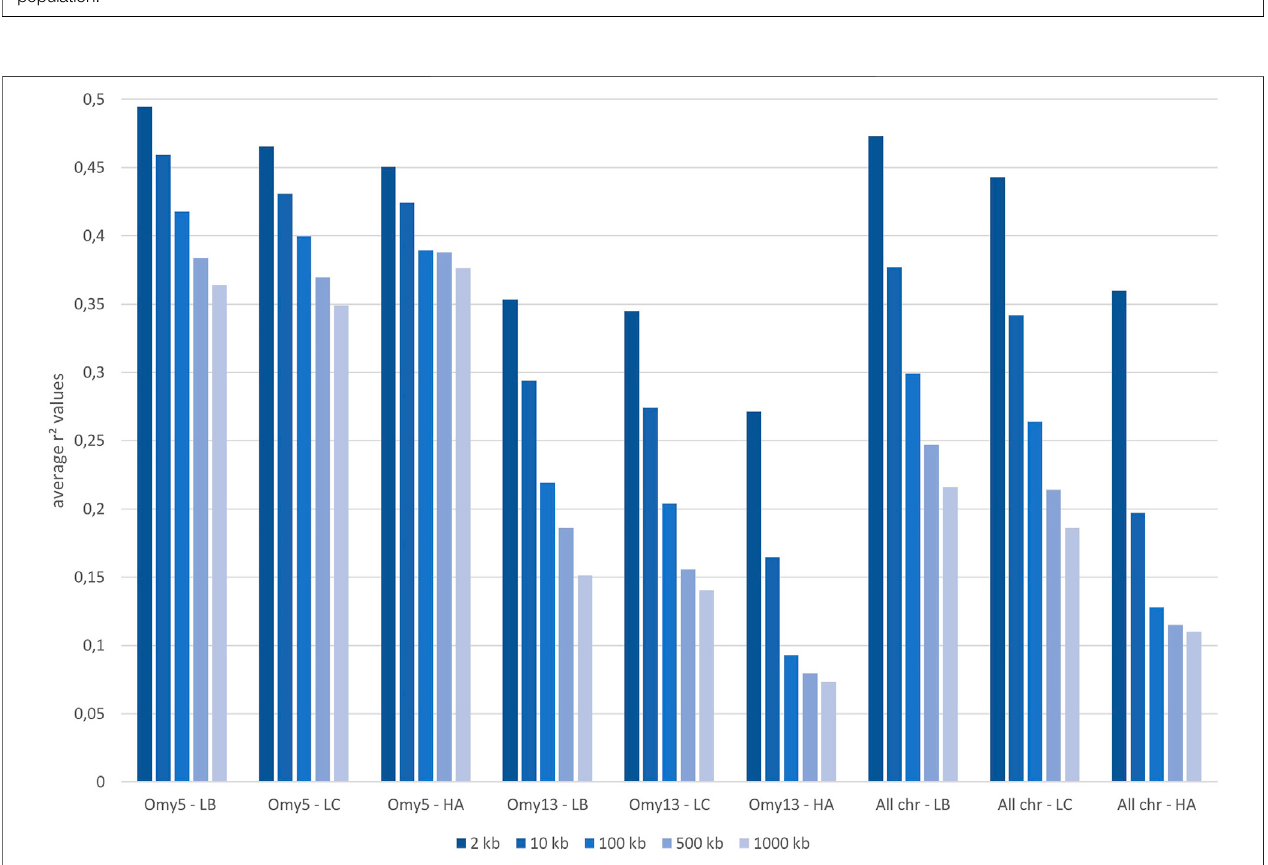
FIGURE8| Averagelinkagedisequilibrium(r2values)from2to1,000 kbderivedforallchromosomesandonlyforOmy5orOmy13inpopulationsLB,LC,andHA, respectively.